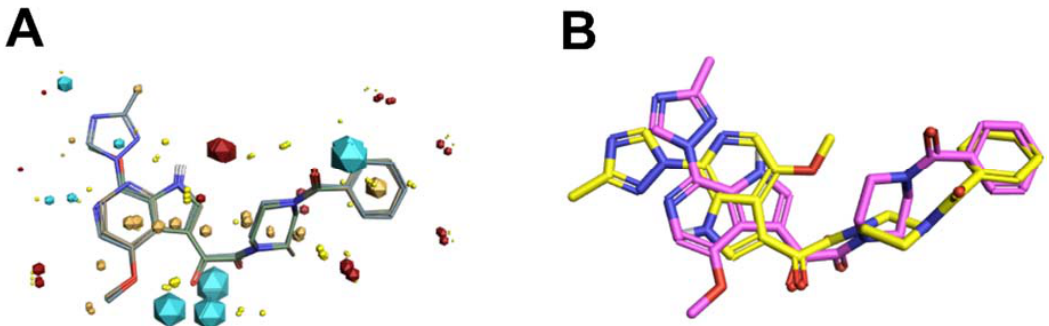
Figure 11. ( A ) Field ‐ based template containing a single conformation of compounds BMS ‐ 378806 (pink), BMS ‐ 488043 (lime green), and BMS ‐ 626529 (teal green) aligned based on their three ‐ dimensional field point patterns. Negatively charged field points are shown in blue; positively charged field points are red; van der Waals/shape field points are displayed in yellow; centers of hydrophobicity are shown in orange. The dodecahedral size of the field points is proportional to the magnitude of the extrema. ( B ) Structural superimposition of BMS ‐ 62529 conformer generated with FieldTemplater (pink) and experimentally obtained crystal structure in complex with HIV ‐ 1 BG505 SOSIP.664 (yellow, PDB code: 5U7O).